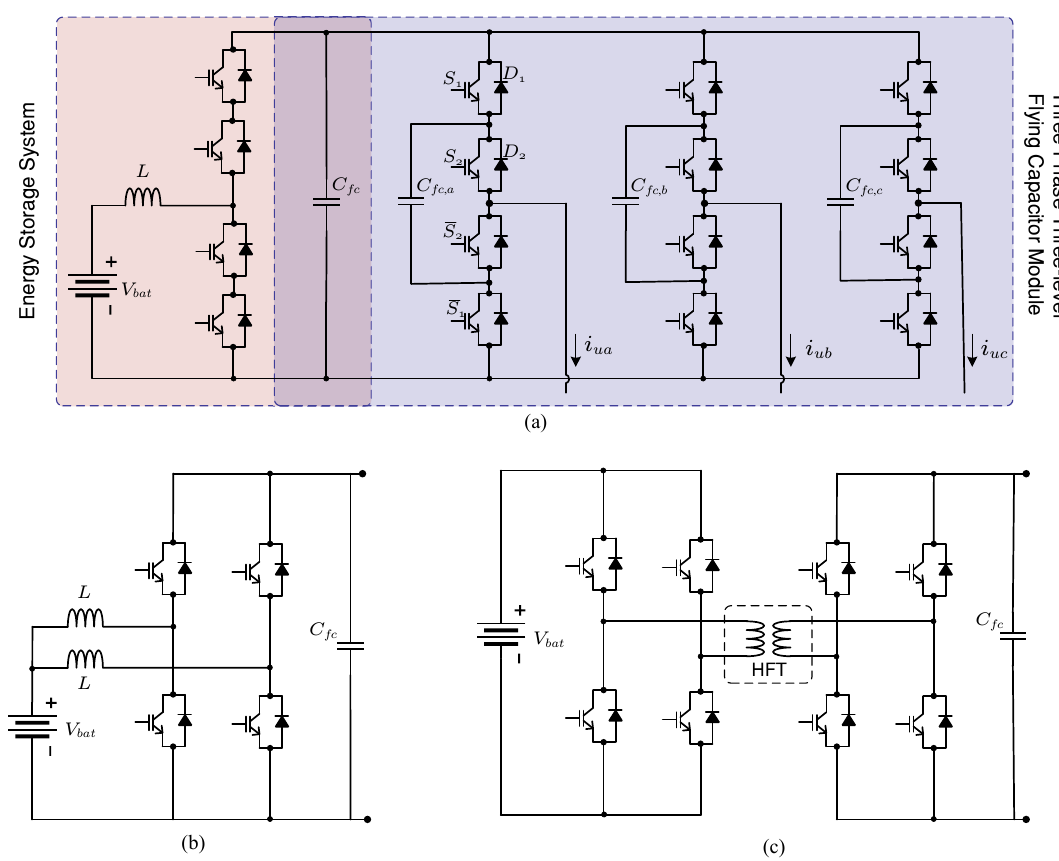
Figure 5. ( a ) FC-SM with embedded energy storage; ( b ) interleaved DC-DC stage; ( c ) isolated DC-DC stage based on the dual-active bridge (DAB)